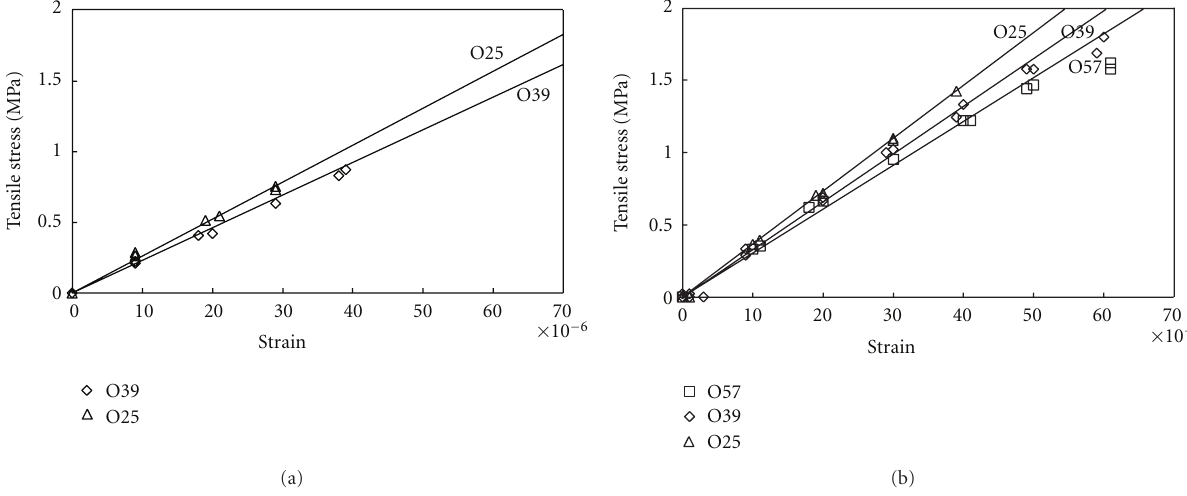
Figure 8: Tensile stress-strain responses: (a) age of 1 day and (b) age of 7 days.